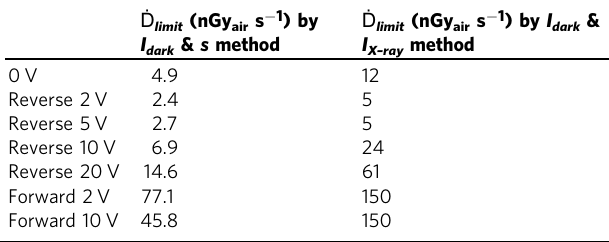
I s ) method vs dark &